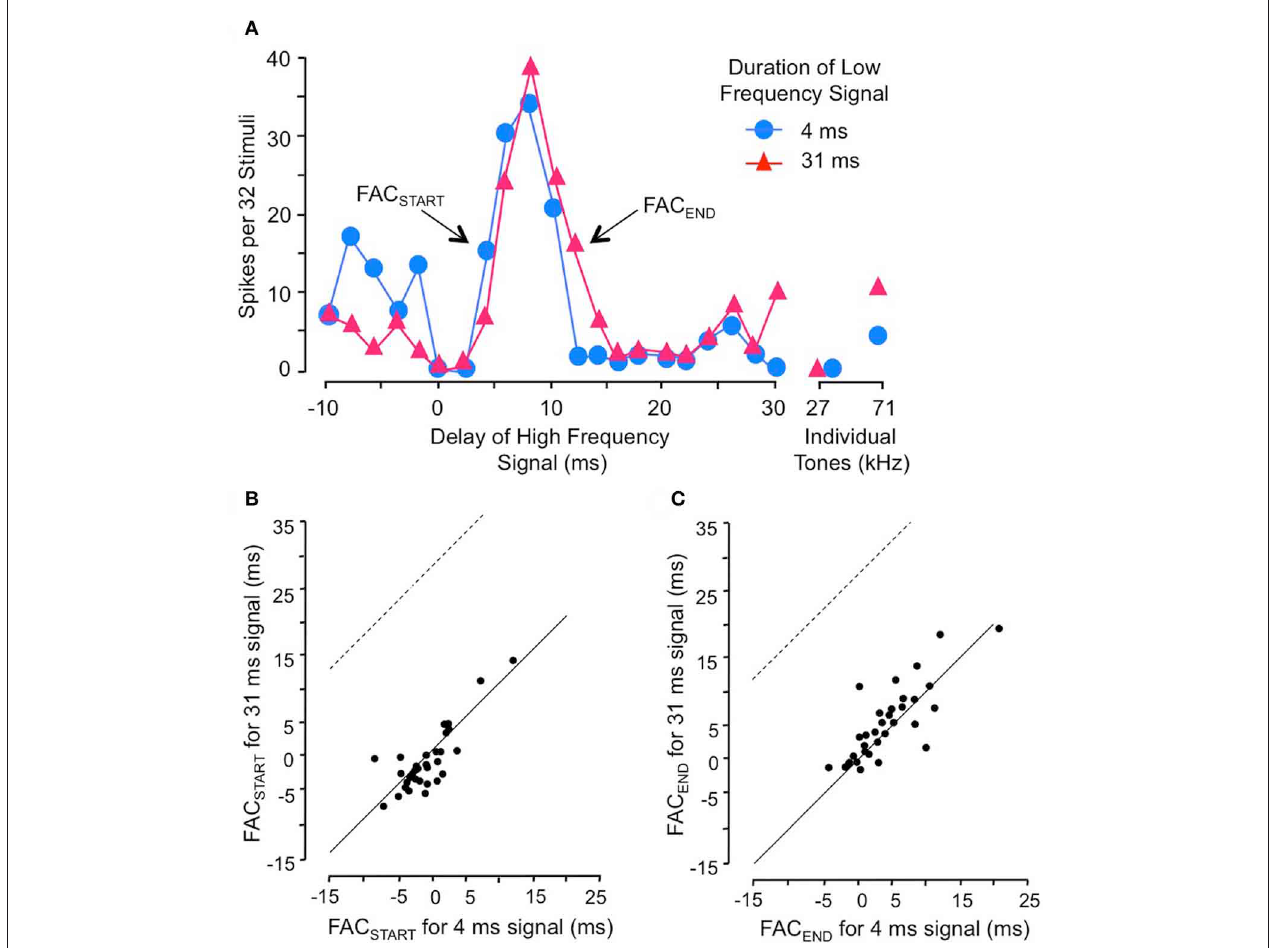
FIGURE 5 | Facilitation in combination-sensitive neurons is activated by the onset of the low-frequency signal and is phasic. (A) Delay sensitivity of neuron was tested with two durations of low-frequency signal. (B) FAC START in scatterplot refers to the shortest delay that evokes facilitation. Data points fall along the solid line, indicating that the change in low-frequency duration had no effect on this measure. Thus, facilitation is locked to the onset of the low-frequency signal. If the facilitation was locked